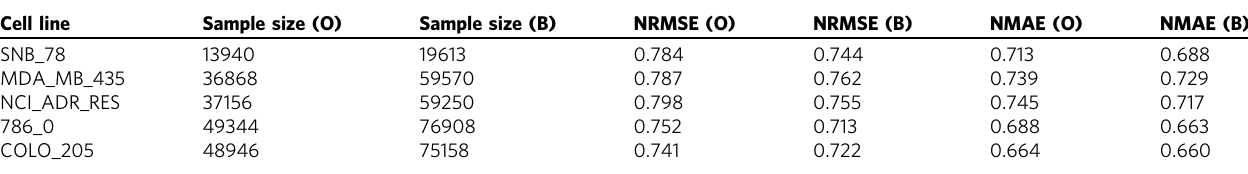
Table 1 Effect of bootstrap data augmentation on REFINED-CNN